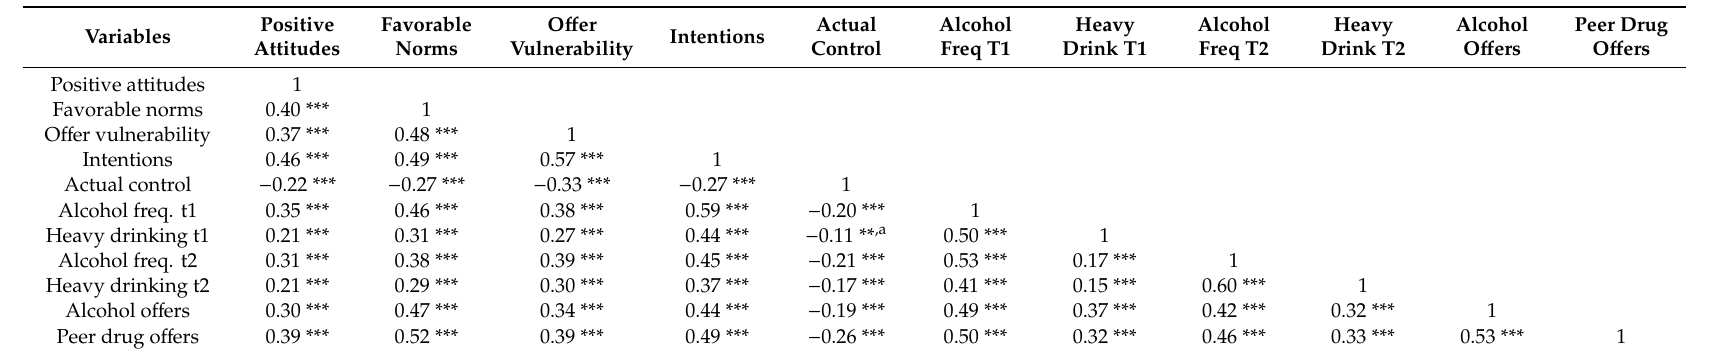
Table 2. Bivariate Correlations Between the Main Variables of the Study for the Total Sample.